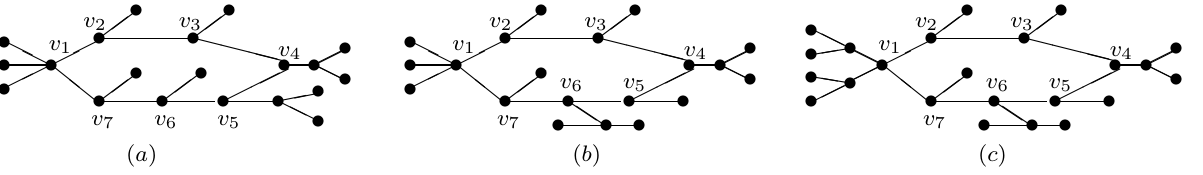
Figure 6. ( a – c ) Three examples of Case 2 with the proof of Lemma 7.